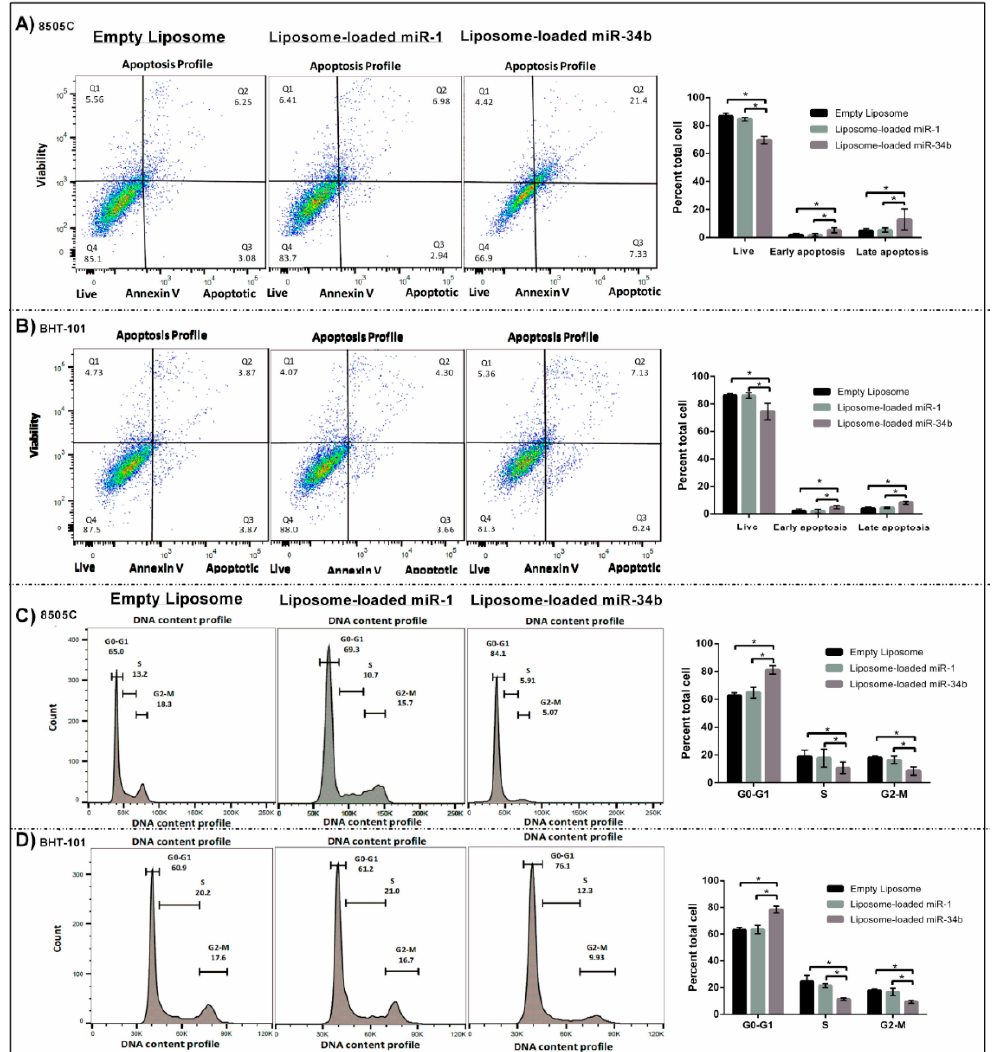
Figure 4. Effect of miR ‐ 34b overexpression on apoptosis and cell cycle kinetics of thyroid carcinoma cells . Thyroid cancer cell lines transfected with liposome ‐ loaded miR ‐ 34b liposome ‐ loaded miR ‐ 1 and empty liposome for 48 h. Apoptosis level of 8505C ( A ) and BHT ‐ 101 ( B ) were determined using Annexin V/propidium iodide (PI) staining and flow cytometry analysis. In both cancer cell lines, miR ‐ 34b overexpression decreased the total number of apoptotic cells in early and late apoptosis phase. Data were shown as mean ± SD of three independent experiments and represent the percent of AnnexinV ‐ positive cells with miR ‐ 34b ‐ 5p related to liposome ‐ loaded miR ‐ 1 and empty liposome treatment groups. The percentage of dead cells (Q1; upper left quadrant), live cells (Q4; lower left quadrant), late apoptosis cells (Q2; PI+/Annexin V+; upper right quadrant) and early apoptosis cells (Q3; PI ‐ /Annexin V+; lower right quadrant) were indicated. Cell cycle analysis revealed that miR ‐ 34b overexpression caused significant accumulations of cancer cells of 8505C ( C ) and BHT ‐ 101 ( D ) cells in G0 ‐ G1 phase after 48 h of transfection with liposome ‐ loaded miR ‐ 34b when compared to liposome ‐ loaded miR ‐ 1 and empty liposome transfected control group. Nuclei of the cells were stained with propidium iodide (PI) solution and analysed for DNA content by flow cytometry. Data were shown as mean ± SD of three independent experiments and represent the percentage of cells in different phases of the cell cycle with liposome ‐ loaded miR ‐ 34b related to liposome ‐ loaded miR ‐ 1 and empty liposome treatment. Flow cytometry results indicated the cell number increased in G0 ‐ G1 phase and decreased in S and G2 ‐ M phases when compared with liposome ‐ loaded miR ‐ 1 and empty liposome